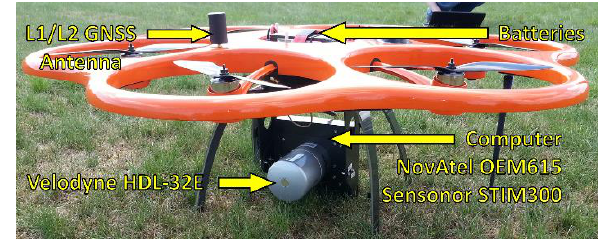
Figure 1. UAS used to collect LiDAR data.